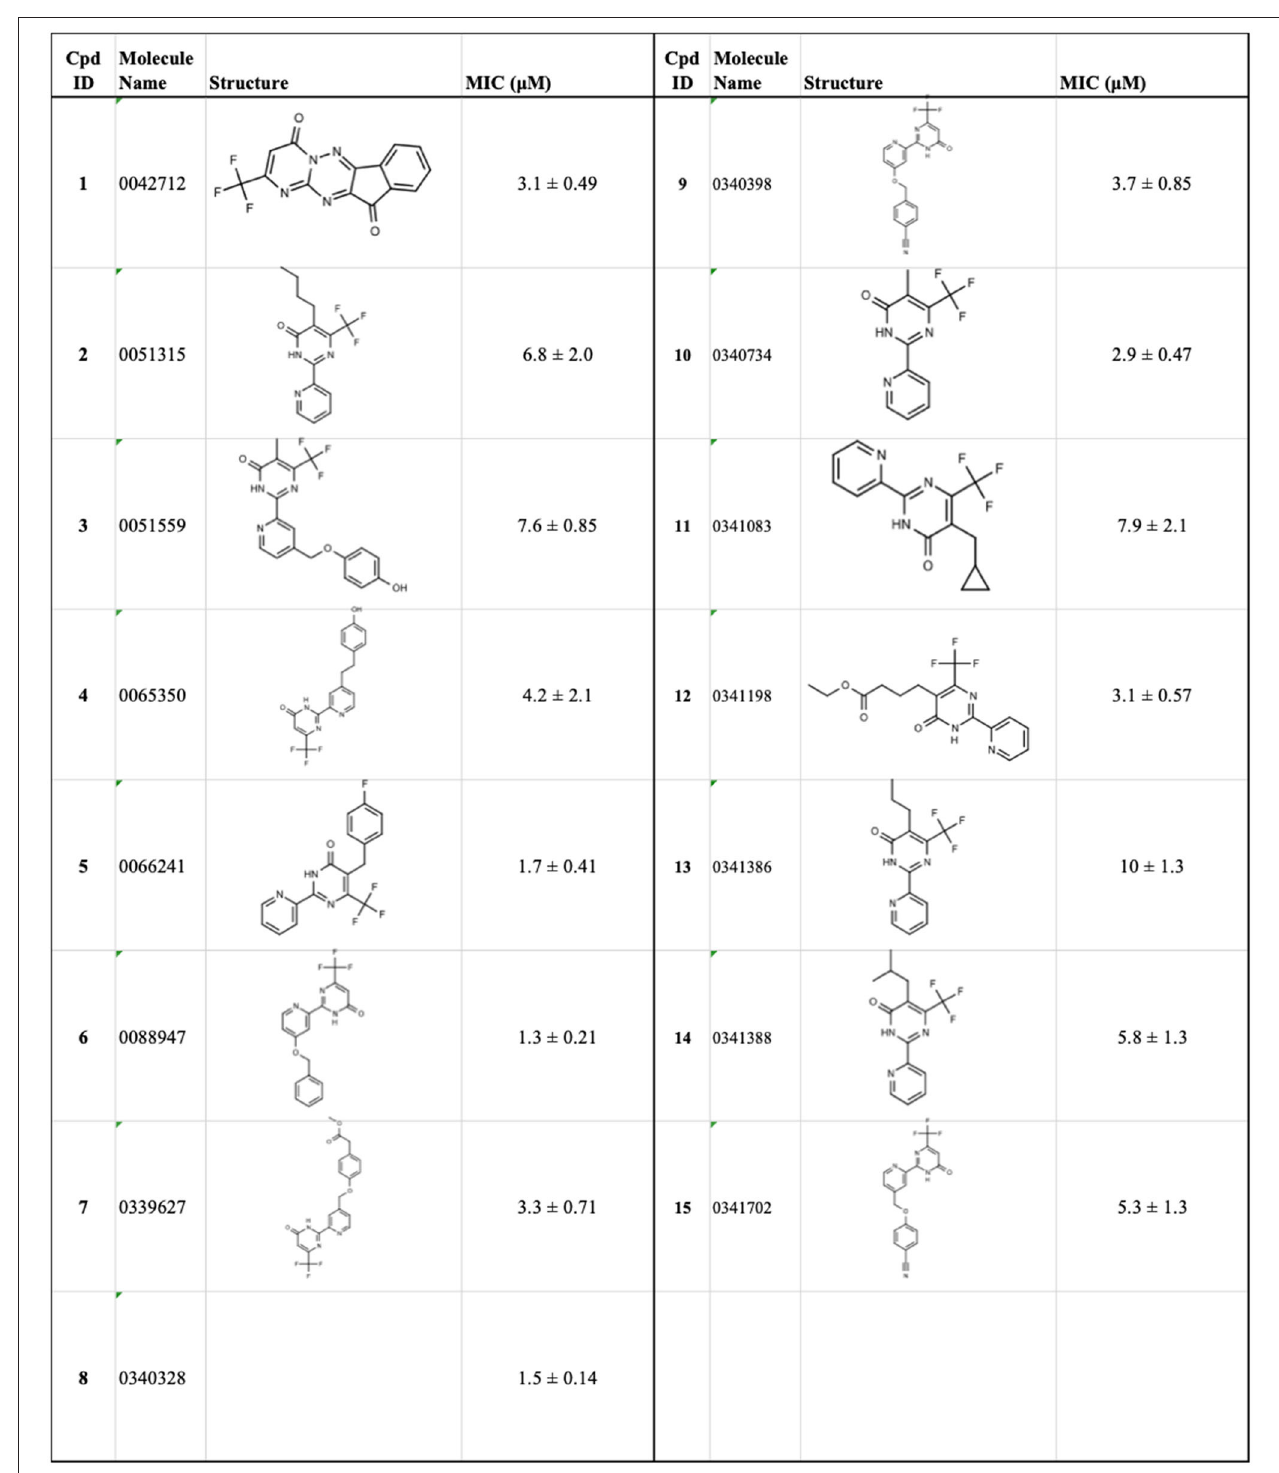
FIGURE 1 | Primary hits. MTB IC 90 is the concentration required to inhibit M. tuberculosis growth by 90%. Data are the average of a minimum of two independent experiments ± standard deviation.